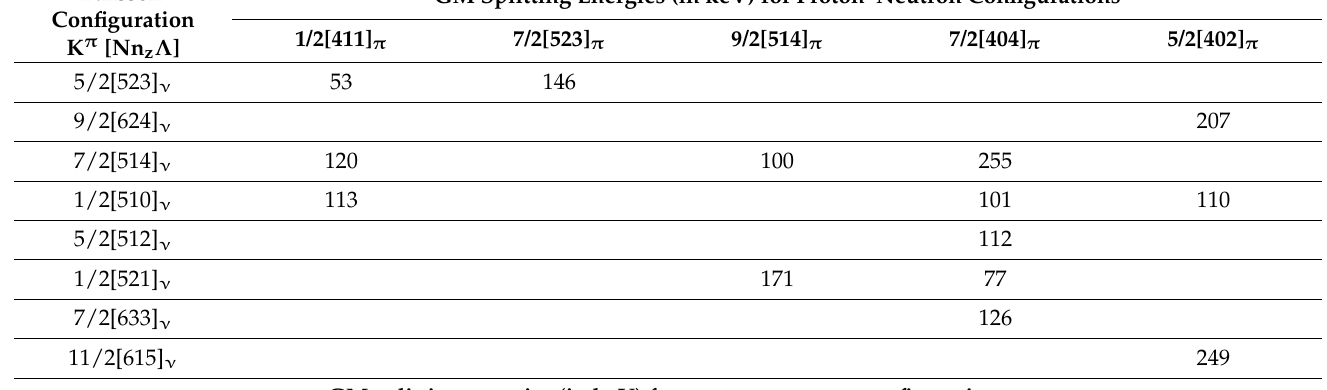
Table 2. GM splitting and Newby shift energies (in keV) extracted for proton–neutron, neutron– neutron and proton–proton 2qp configurations observed in neighboring even–even and odd–odd